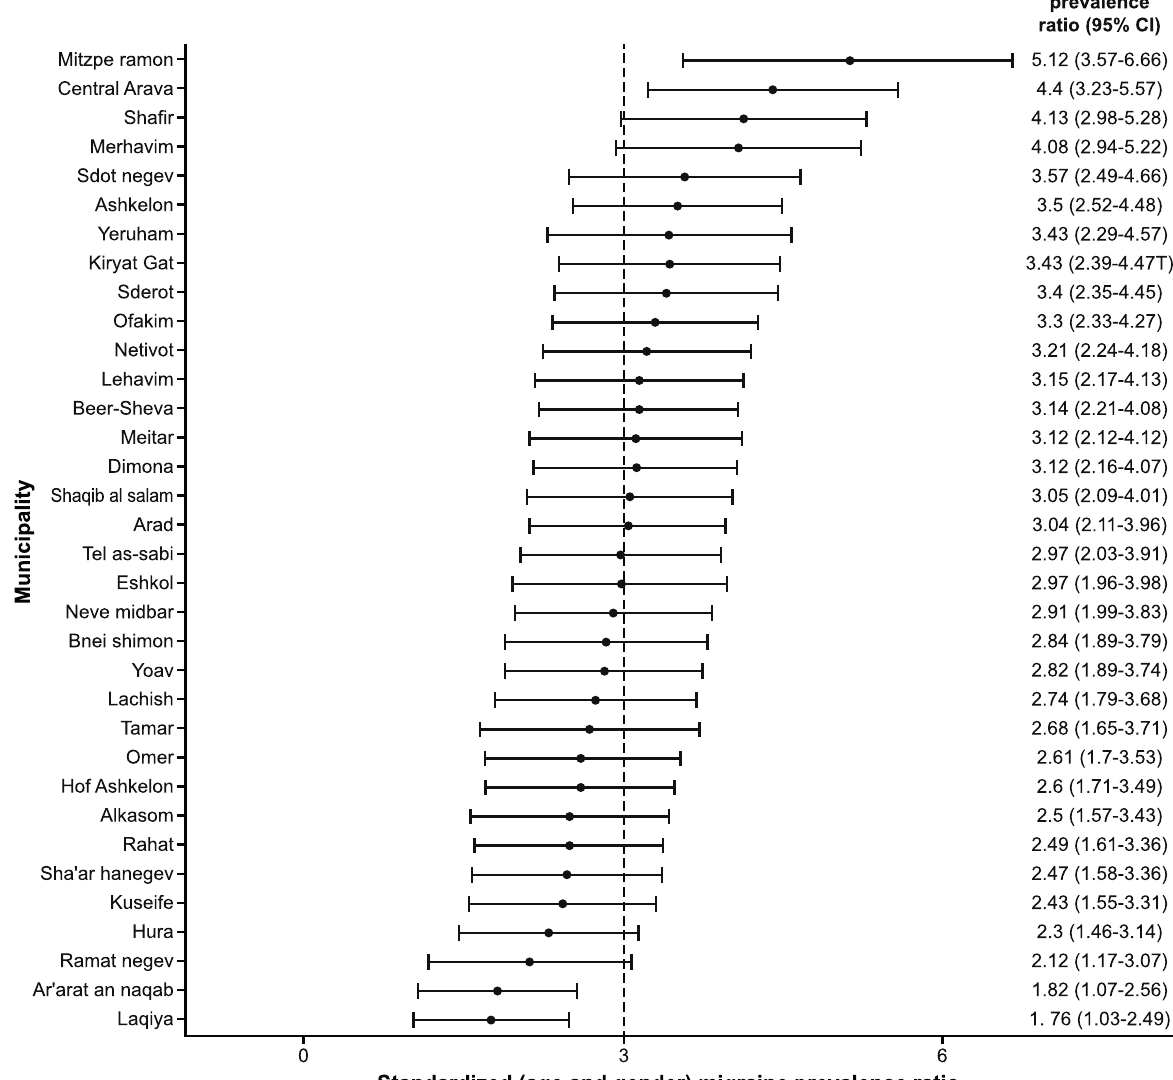
Fig. 3 Age-adjusted female-to-male ratios. CI, confidence